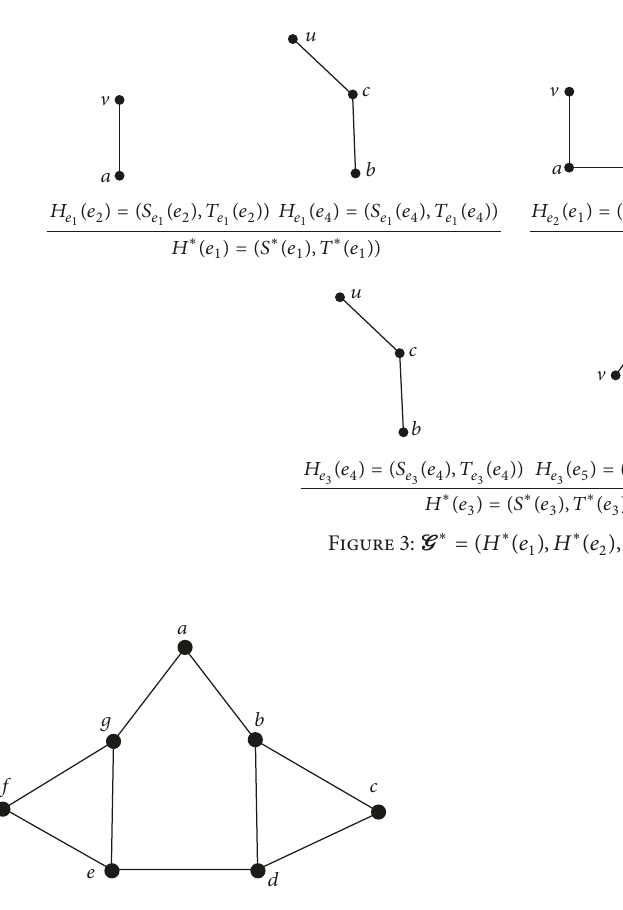
Figure 4: Undirected